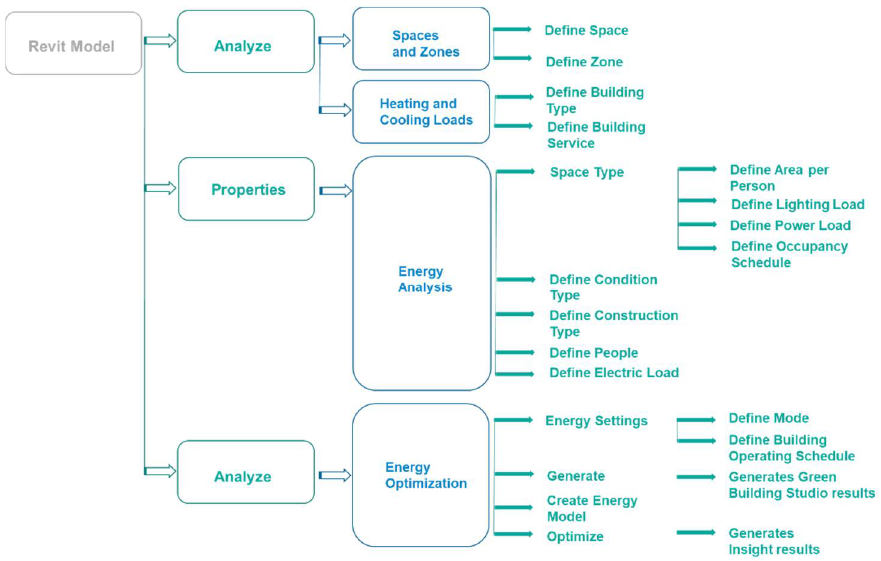
Figure 2. BIM-BEM integration